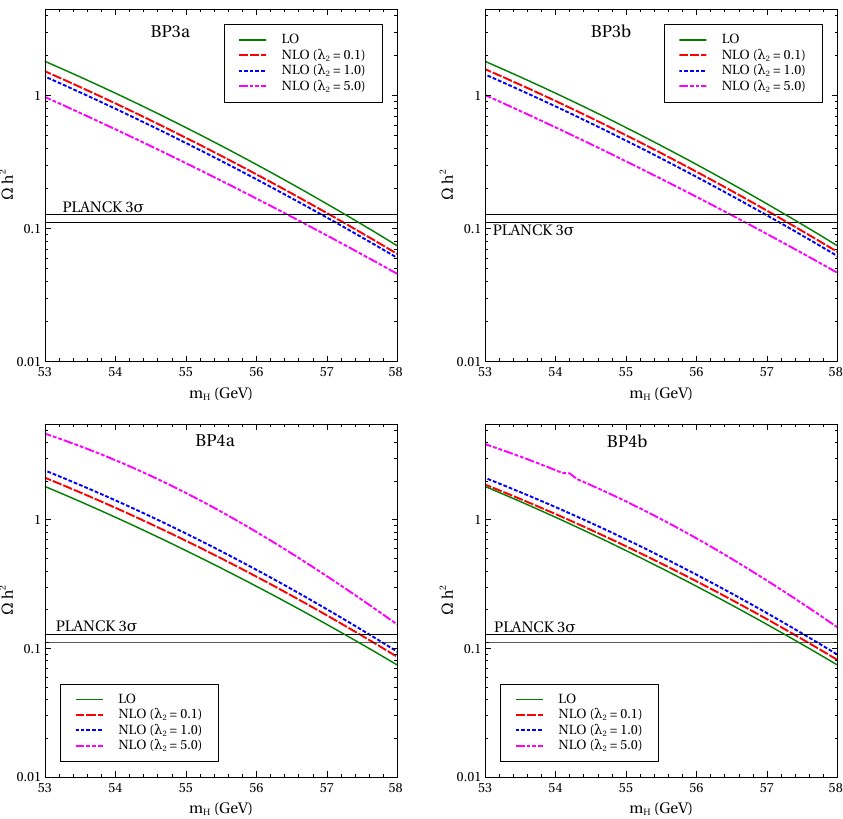
Figure 4 . The same as in (cid:12)gure 3 for BP3a, BP3b, BP4a and